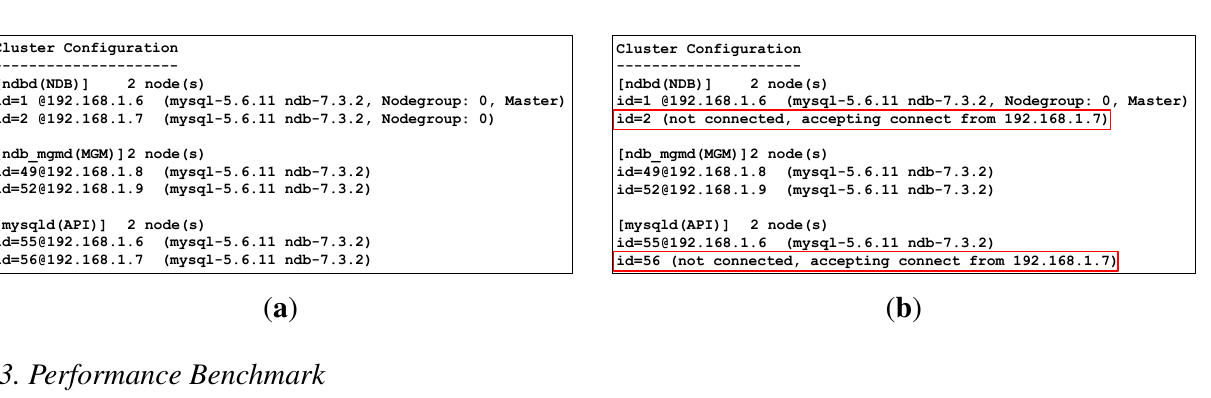
Figure 17. Snapshot of ndb mgm client showing the most current MySQL Cluster configuration: ( a ) Both data and SQL node hosts are up and running; ( b ) One data and SQL node host (192.168.1.7) are